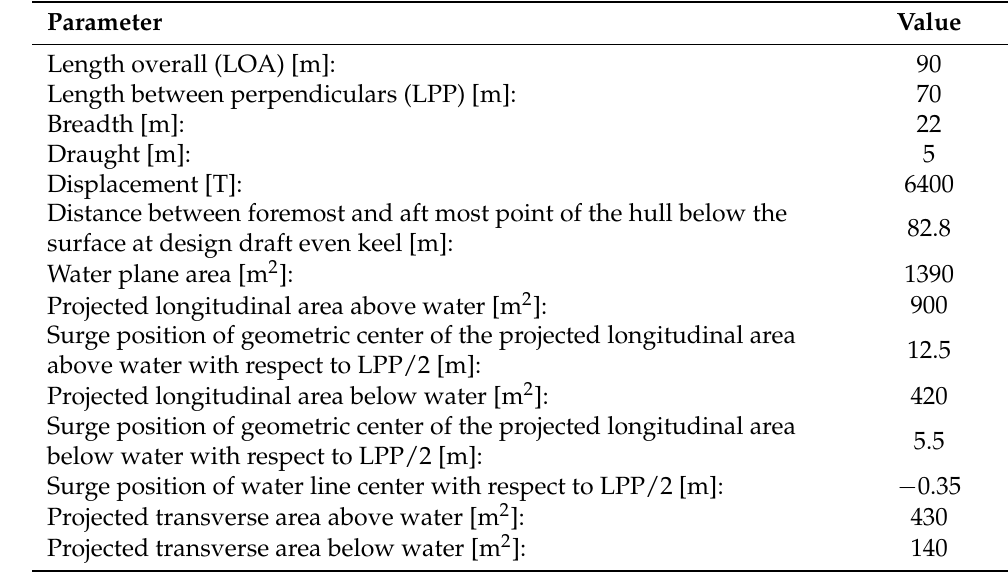
Table 2. Data for ship with conventional positioning system.